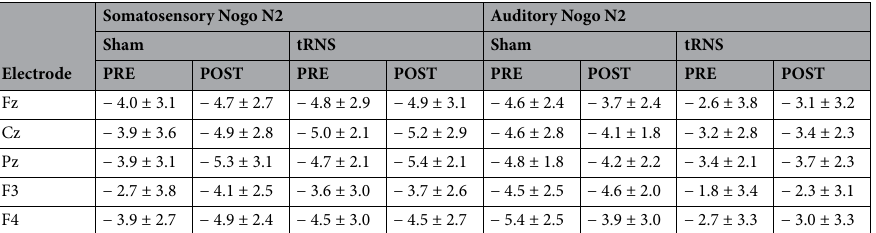
Table 1. The peak amplitude ± SD of somatosensory and auditory Nogo